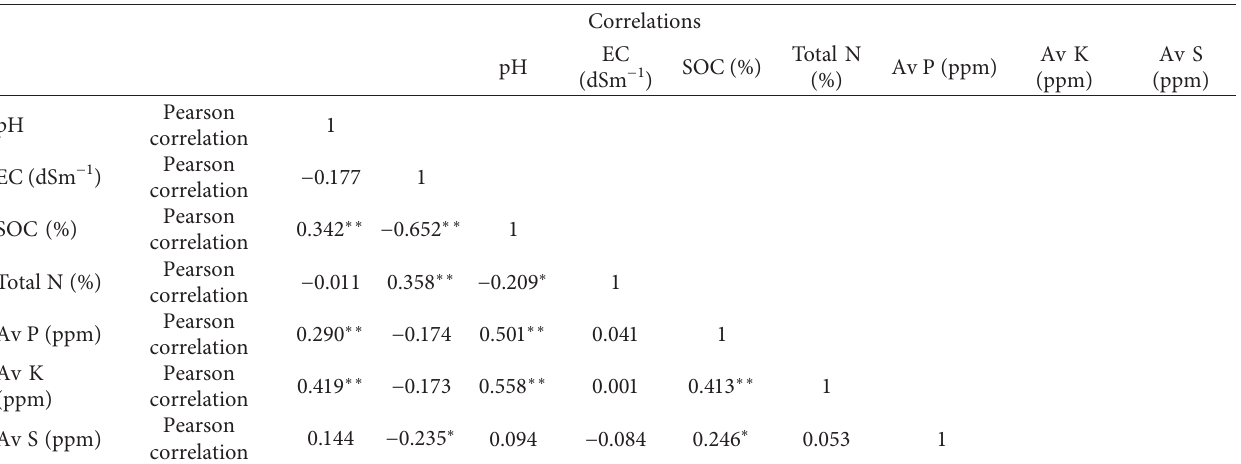
Table 2: Correlation matrix based on Pearson’s correlation coefficients among soil chemical properties in the study